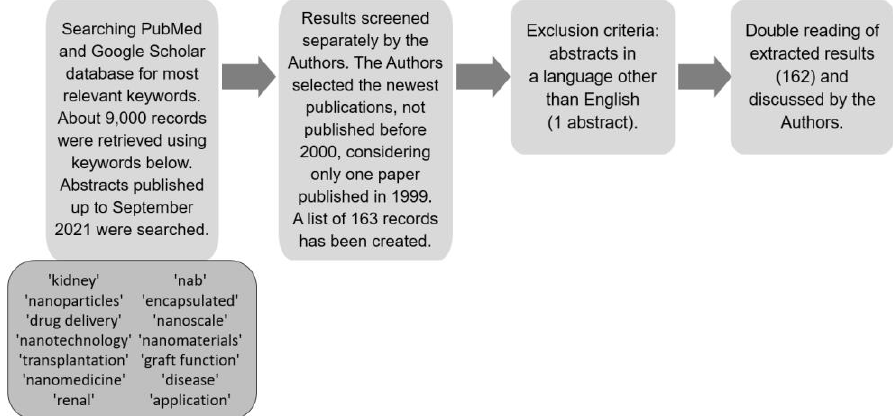
Figure 1. Strategy of data collection presented as a flow diagram.